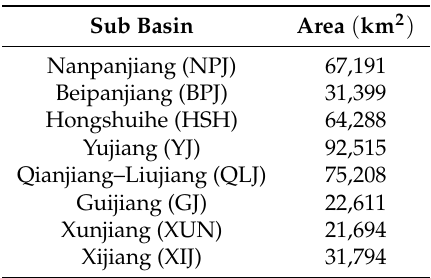
Table 1. The area of each sub-basin over Xijiang